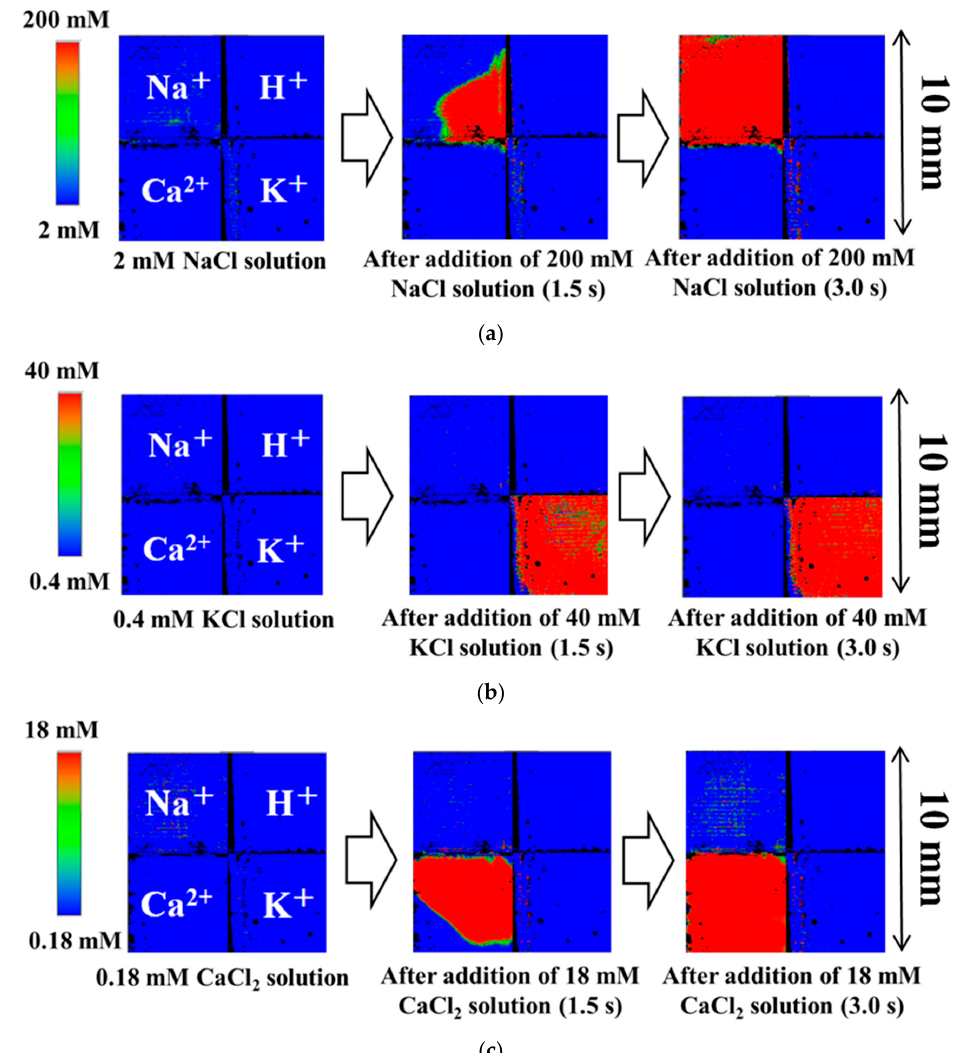
Figure 6. Snapshots of CCD multi-ion image sensor with 128 × 128 pixels array. ( a ) 200 mM sodium ion solution (100 µ L) was injected into a 400 µ L of sample solution including 2 mM sodium ion solution by a pipette; ( b ) 40 mM potassium ion solution (100 µ L) was injected into a 400 µ L of sample solution including 0.4 mM potassium ion solution by a pipette; ( c ) 18 mM calcium ion solution (100 µ L) was injected into a 400 µ L of sample solution including 0.18 mM calcium ion solution by a